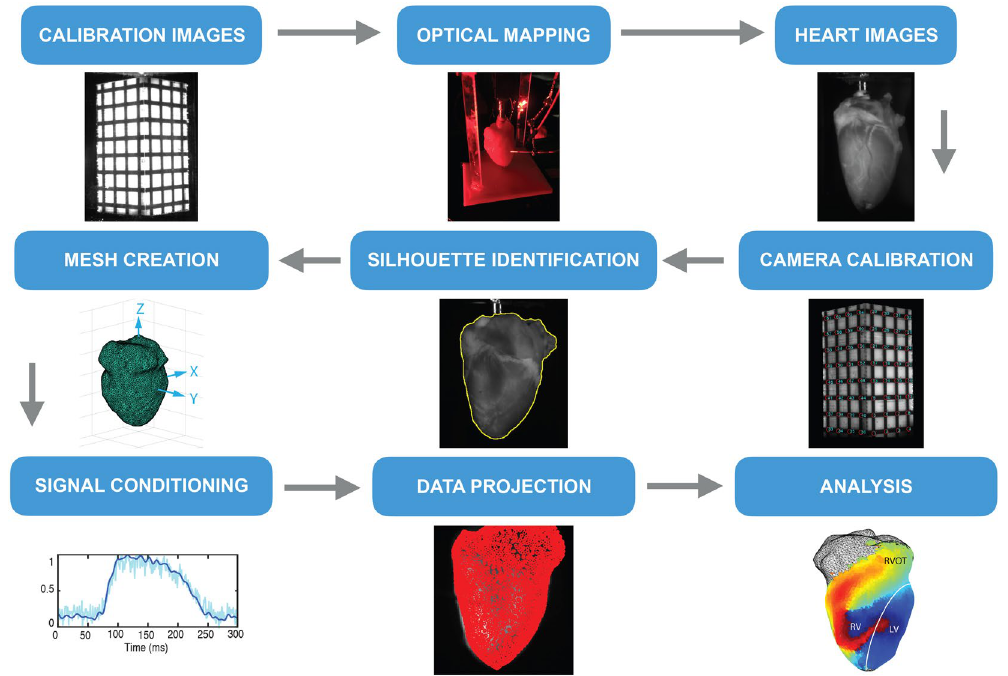
Figure 1. RHYTHM panoramic imaging workflow. Producing panoramic data requires a detailed oriented, step-by-step process. RHYTHM provides a concise and intuitive set of tools for accomplishing